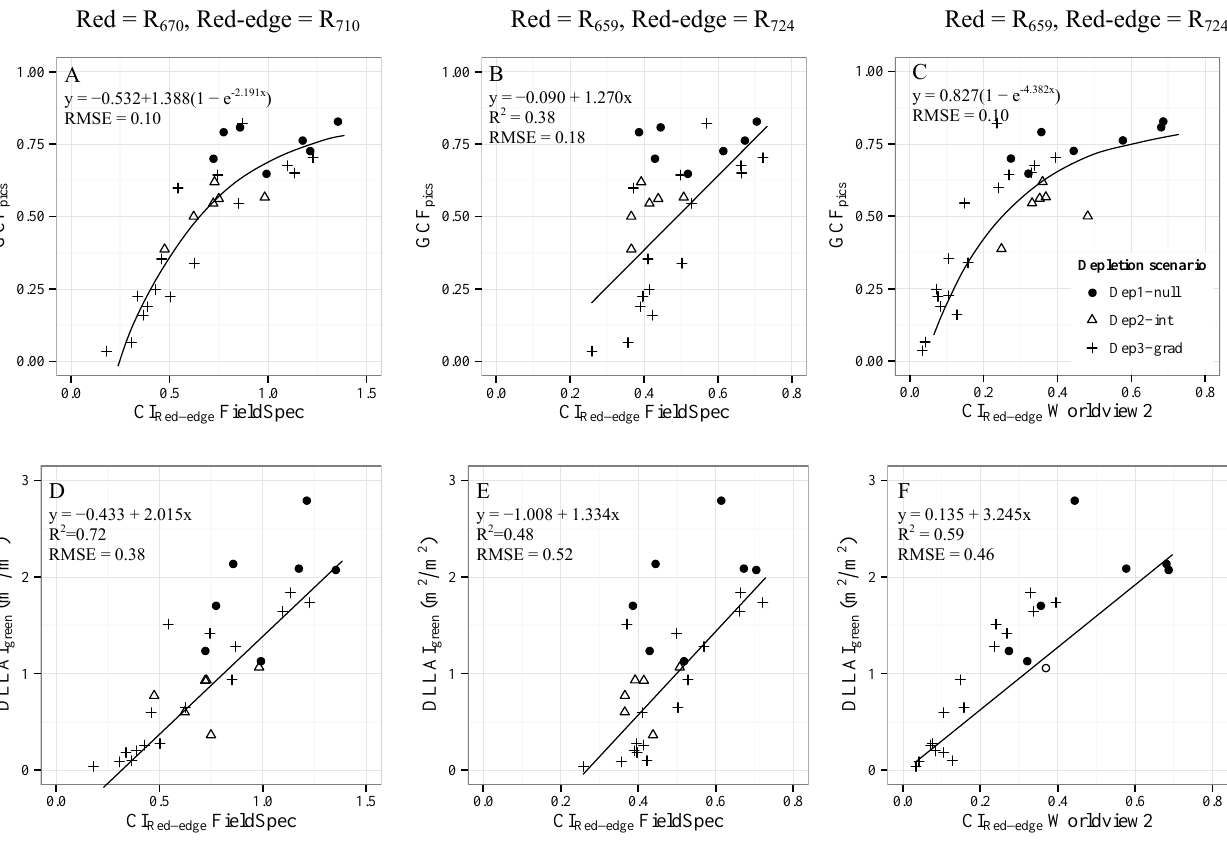
Figure 10. Relationships between CI ( D – F ) for 32 Tamarugo trees. CI two columns) and the WorldView2 broad bands (third